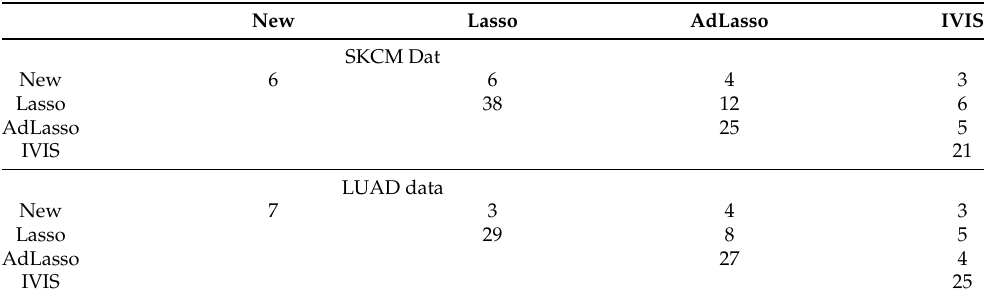
Table A4. Data analysis: comparison of variable selection results. Each cell shows the number of overlapping